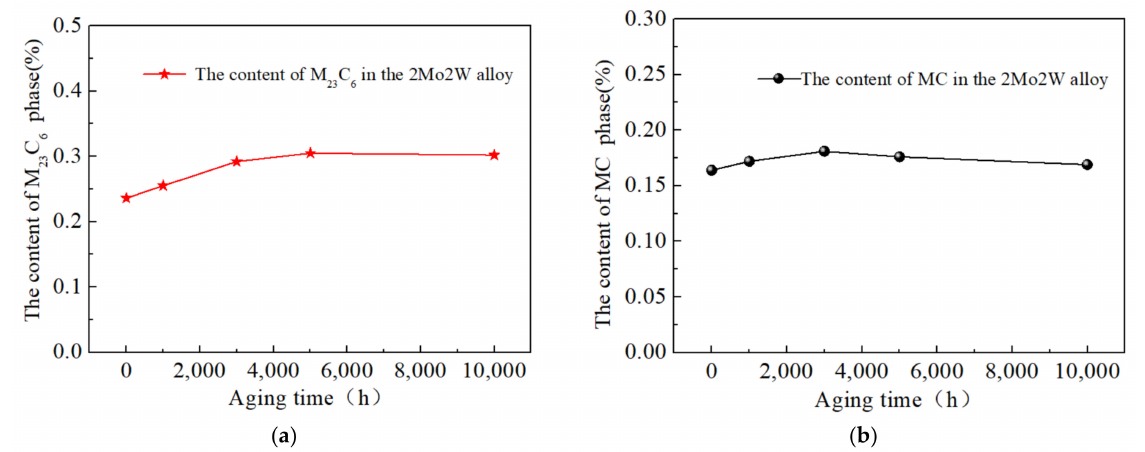
Figure 4. Temporal evolution of the contents of ( a ) M 23 C 6 and ( b ) TiC during long-term treatment at 700 ◦ C.